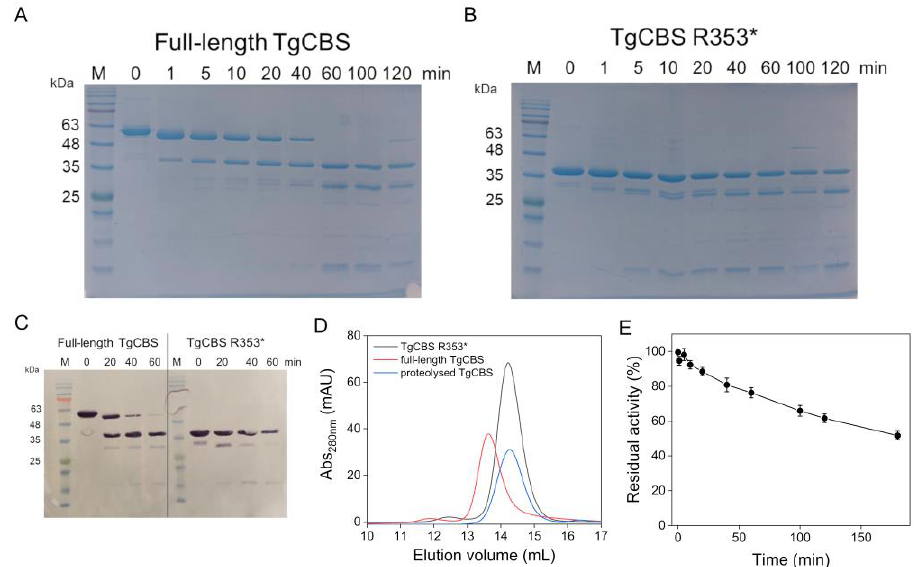
Figure 5. Trypsin cleavage of TgCBS. ( A , B ) Representative time course of trypsin limited proteolysis of ( A ) full-length TgCBS and ( B ) TgCBS R353*. Lane 1: MW marker, lanes 2–9: trypsin digestion products obtained following incubation of protein with trypsin 1:200 ( w/w ) for 0, 1, 5, 10, 20, 40, 60, 100, and 120 min, respectively. ( C ) Western blot analysis after trypsin treatment. At various time, 0, 20, 40, 60 min, proteolyzed products were immunoblotted with anti-His antibodies (Sigma, 1:2000). ( D ) SEC of TgCBS after limited digestion (blue line). Full-length TgCBS (red line) and TgCBS R353* (black line) at 0.5 mg/mL are also shown. ( E ) Time-course of TgCBS activity during